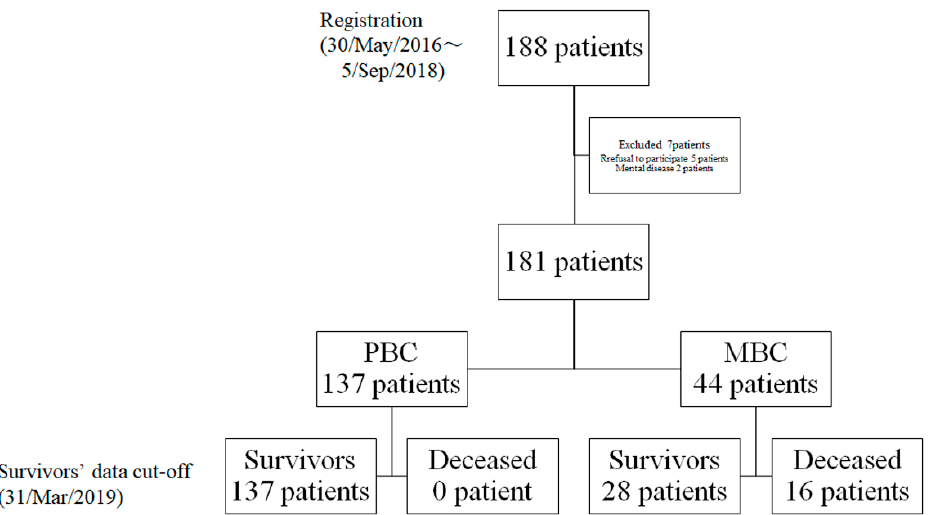
Figure 2. Flowchart depicting patient distribution: PBC, primary breast cancer; MBC, metastatic breast cancer .